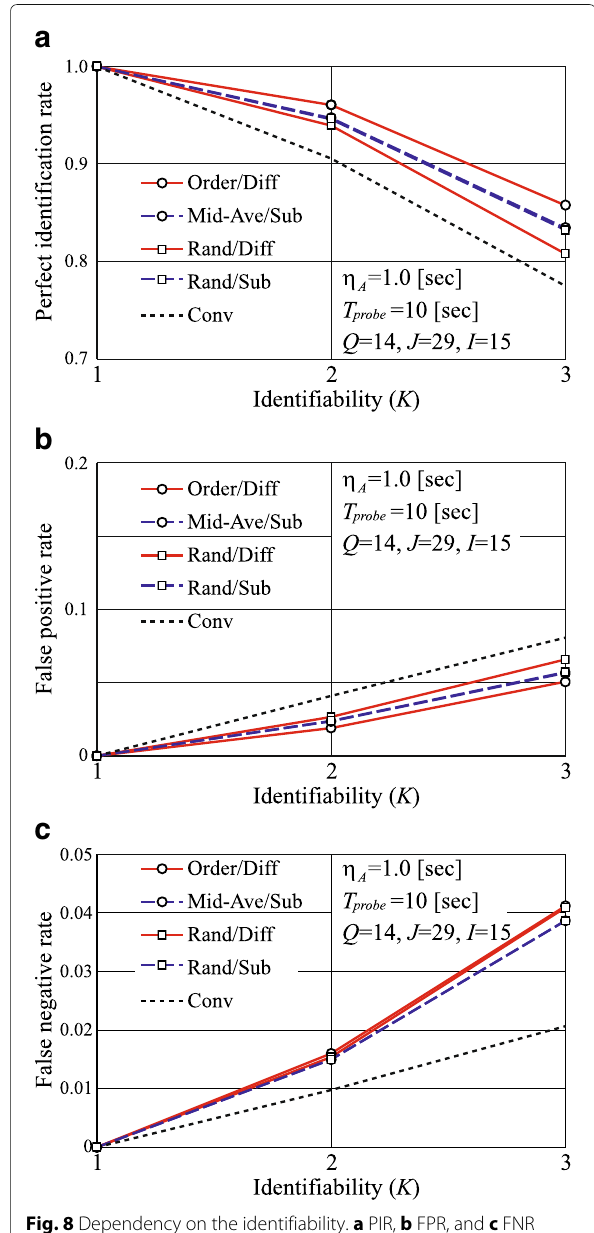
is important to note that the route ordering can be exe- cuted only once in an off-line manner before tomography session.